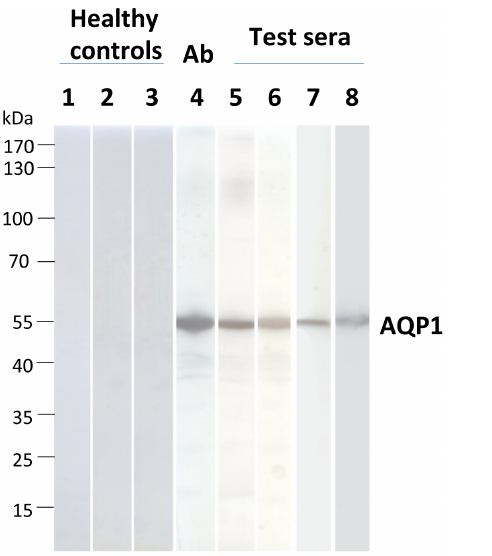
Figure 5. Detection of anti-AQP1 antibodies by an ELISA with immobilized purified human yeast-expressed AQP1 . Sera previously tested by RIPA for AQP1 antibodies were tested for binding to immobilized AQP1 by ELISA. First column contains 31 sera found positive by the RIPA (including a double-positive anti-AQP1/AQP4, empty square, and 3 sera from anti-AQP1-positive MS patients, empty circles). The following 3 columns contain 5 anti-AQP4-positive/anti- AQP1-negative sera, 30 sera from anti-AQP1-negative MS patients and 44 sera from healthy controls). The dashed horizontal line denotes the cut-off (O.D.450: 0.36) for positive